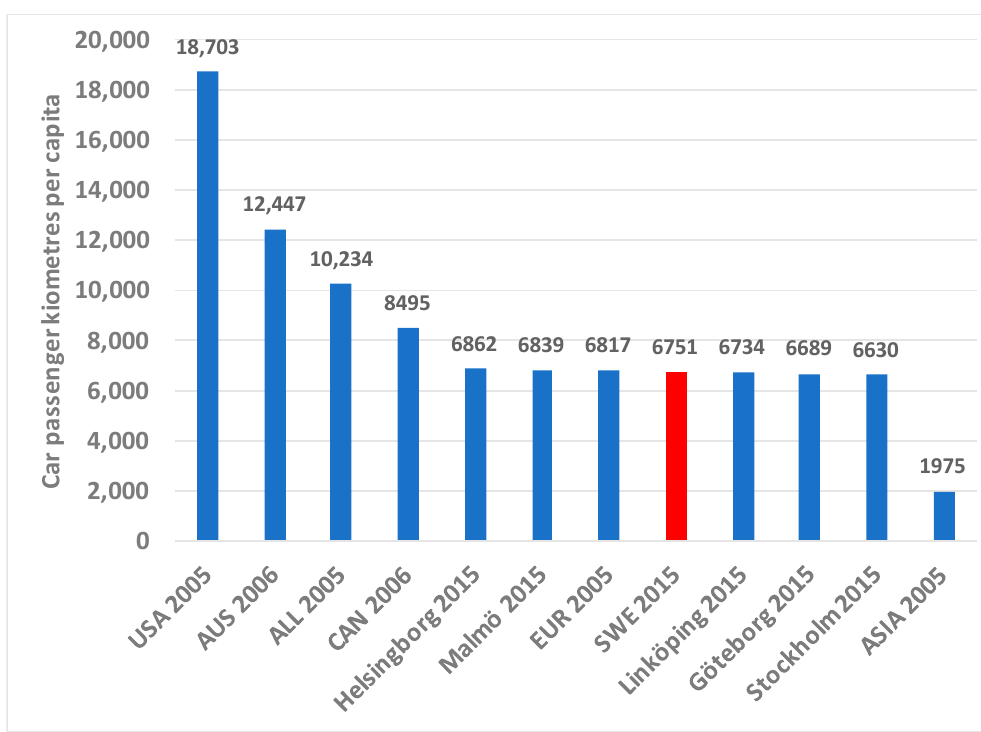
Figure 13. Annual car use per person (PKT) in five Swedish cities (2015) compared to a sample of global cities (2005–2006).